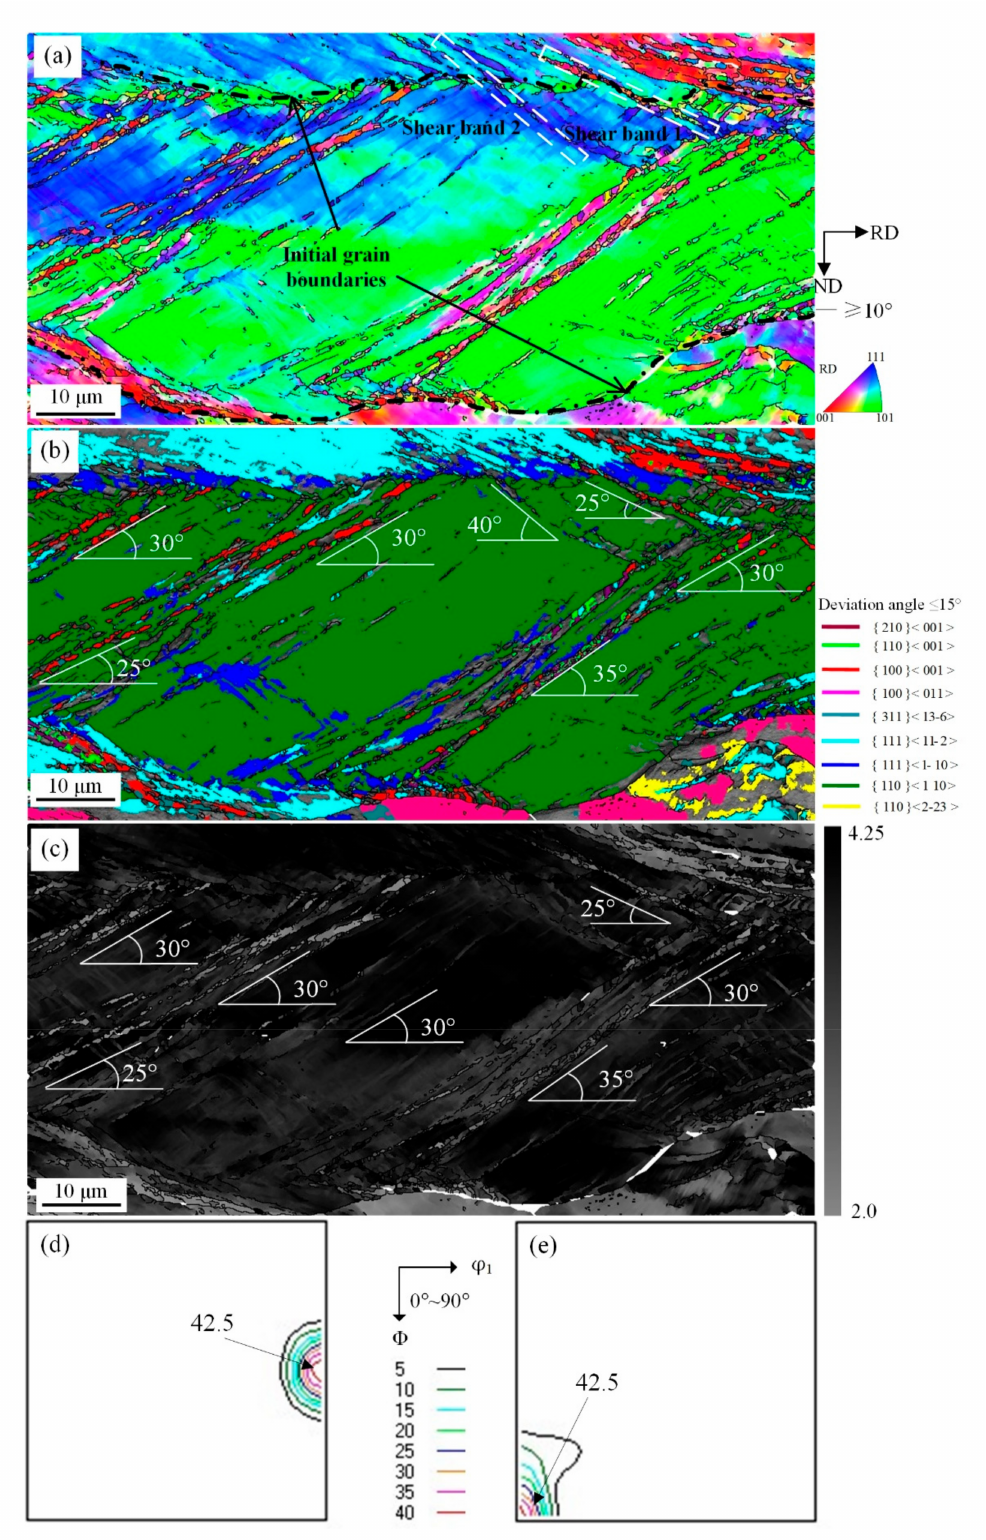
Figure 4. EBSD orientation maps of shear bands with {110}<110> under 57% reduction ( a ) ESBD inverse pole figure of cold-rolled sheet; ( b ) several texture components colored in orientation maps of cold-rolled sheet(deviation angle ≤ 15 ◦ ); ( c ) Taylor factors of shear bands; ( d ) ODF of EBSD data presented at ϕ 2 = 0 ◦ section; ( e ) ODF of EBSD data presented at ϕ 2 = 45 ◦